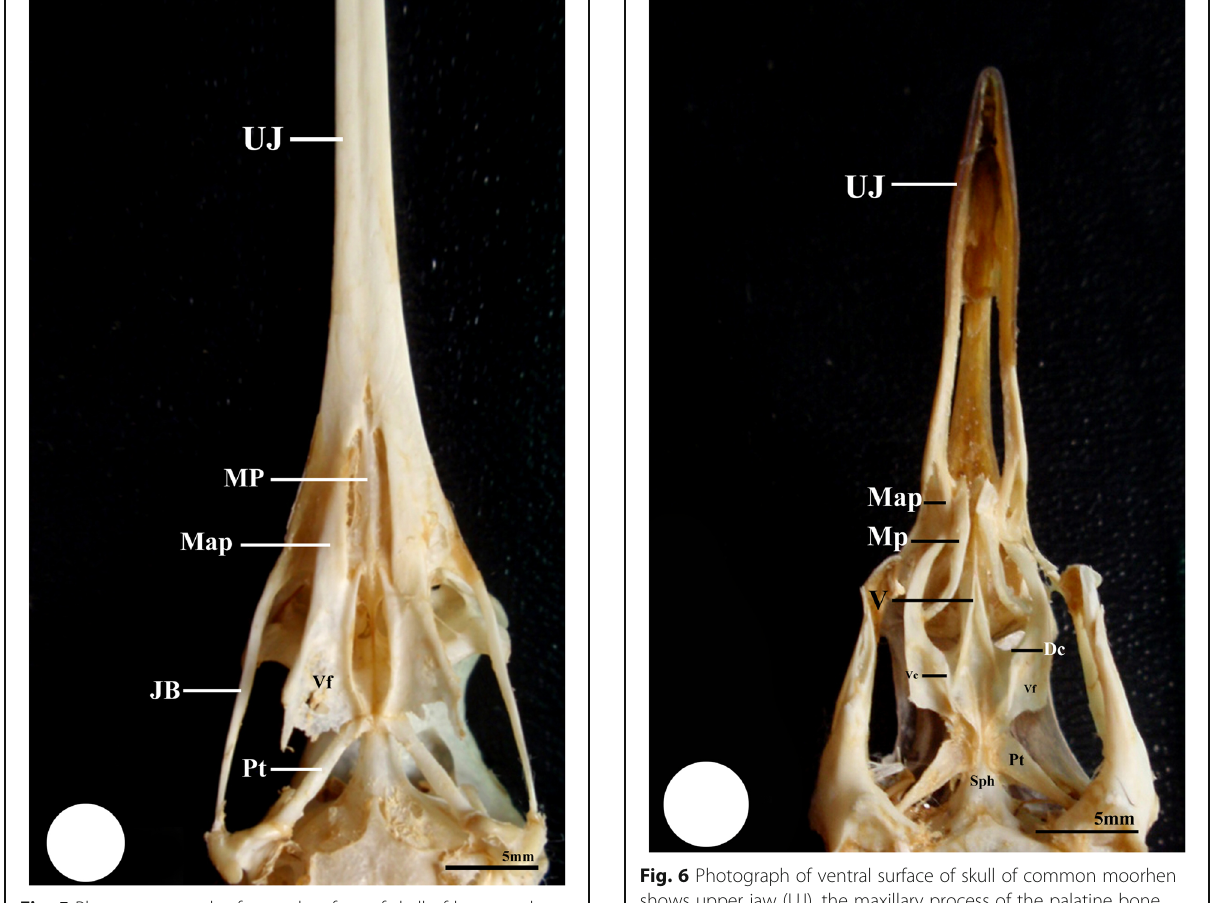
the common moorhen (Fig. 15b). This indicates the presence of carboxylate mucopolysaccharides. In kestrel give deep-bluish color with Alcian-blue PH1 (Fig. 15d, f) rides. In the common moorhen, the glandular cells of choana give deep blue color with Alcian-blue PH1 color (Fig. 15e, g).